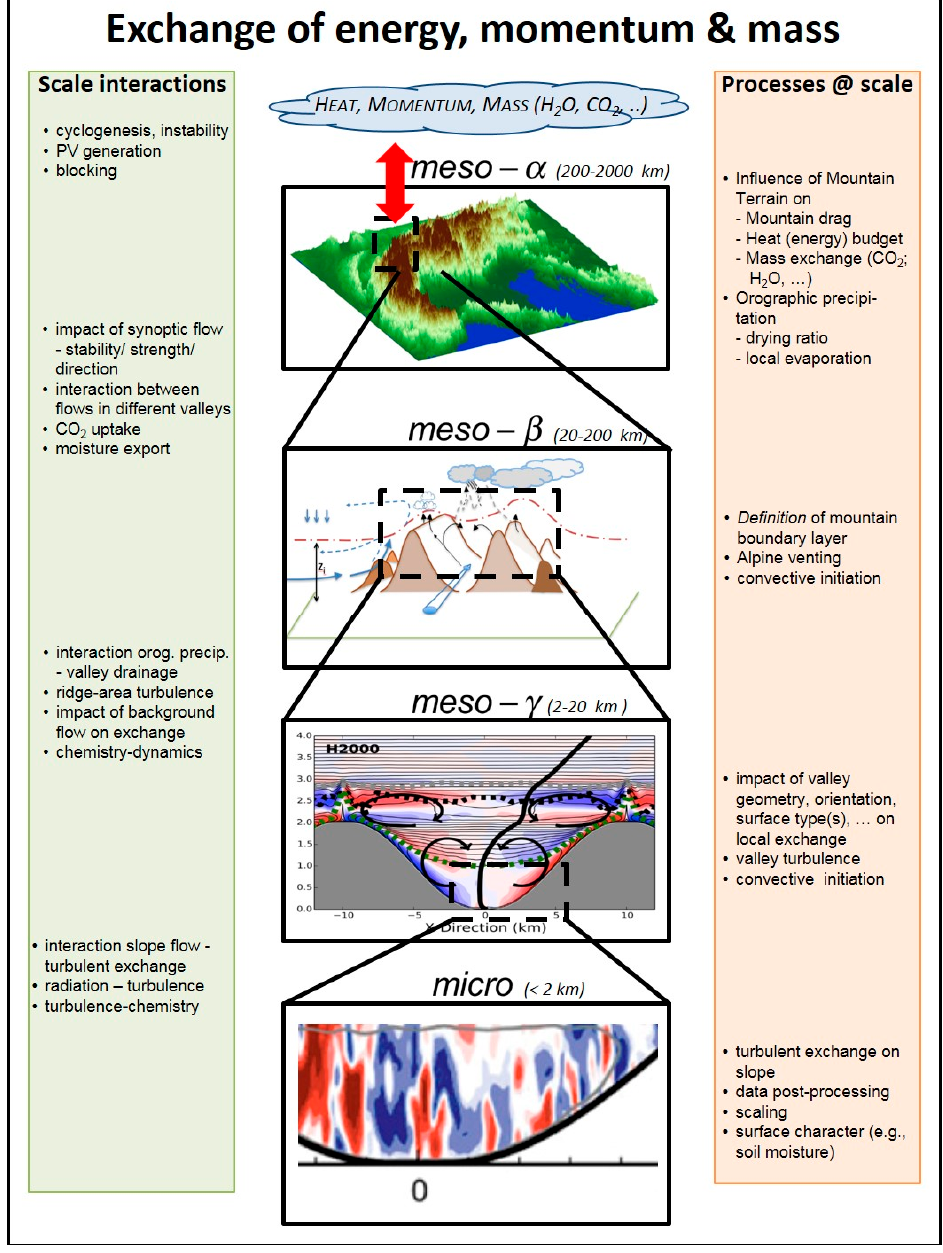
Figure 5. Different scales in mountainous terrain, atmospheric processes on these scales ( right bar) and interactions ( left bar). The top panel in the middle column shows the Alps at 1 km horizontal grid spacing. The middle two panels are from Rotach et al. [6], the lowest panel from Schmidli [69] (© Copyright (2013) American Meteorological Society (AMS)).